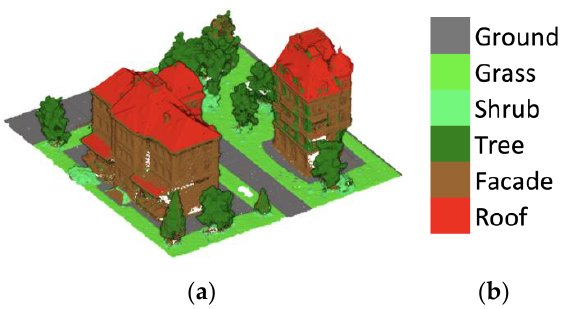
Figure 17. ( a ) Classification result on testing area of the 3DOMCity dataset with our 2DCNN, ( b )